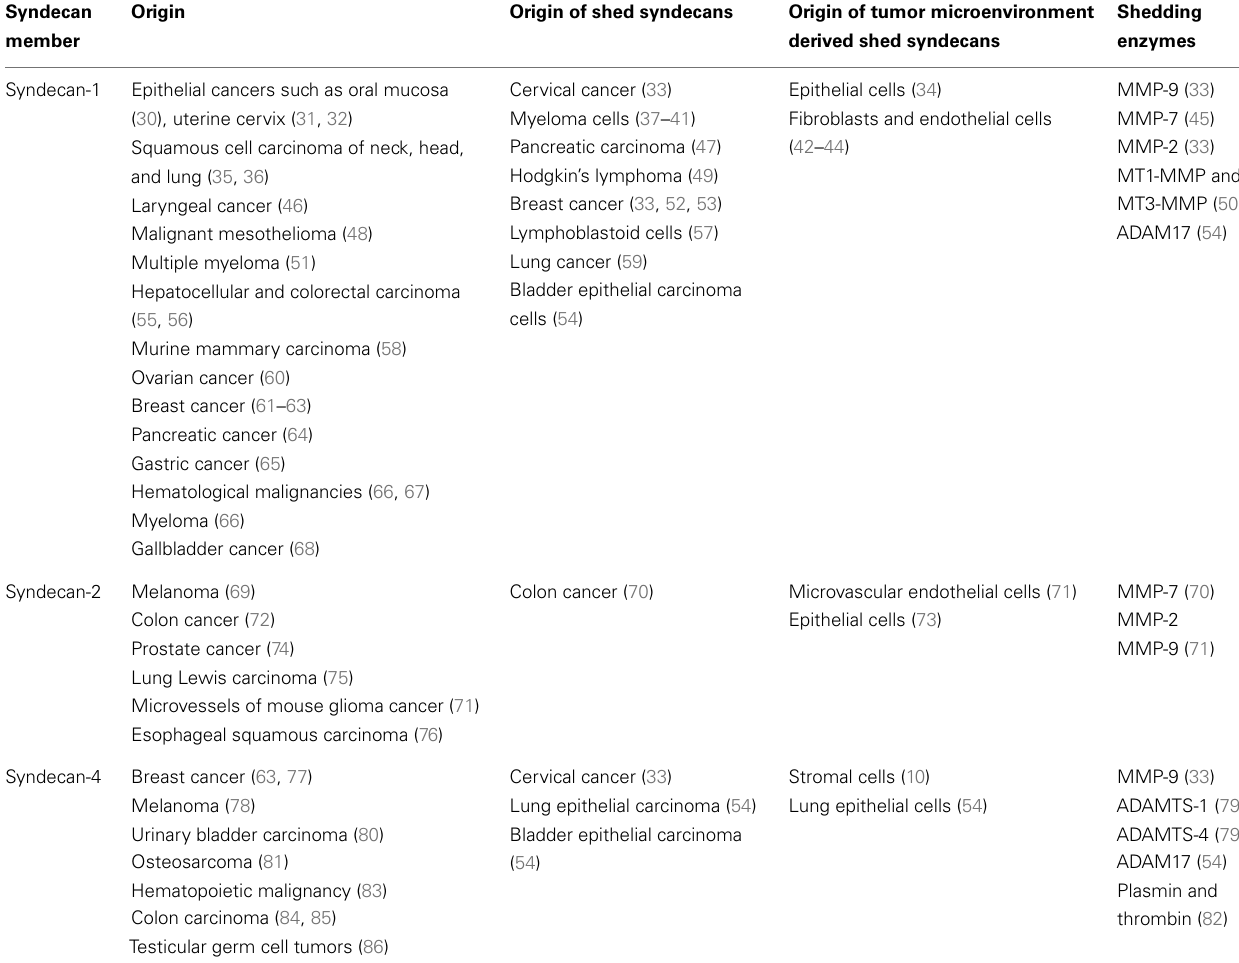
Table 1 | Overview of syndecans expression involving their origin, state, and processing enzymes.